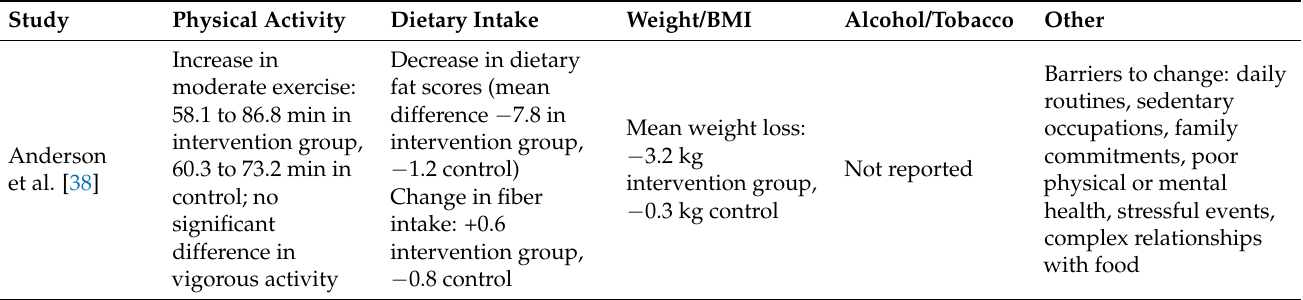
Table 4 details the results of included studies according to the behaviors targeted. Table 4. Summary of findings across targeted behaviors or risk